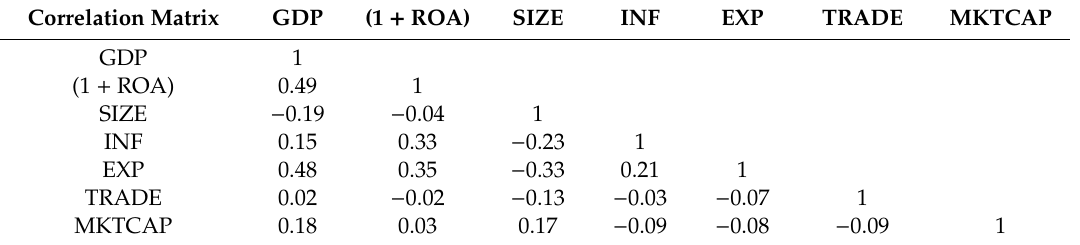
Table A1. Correlation matrix for variables.